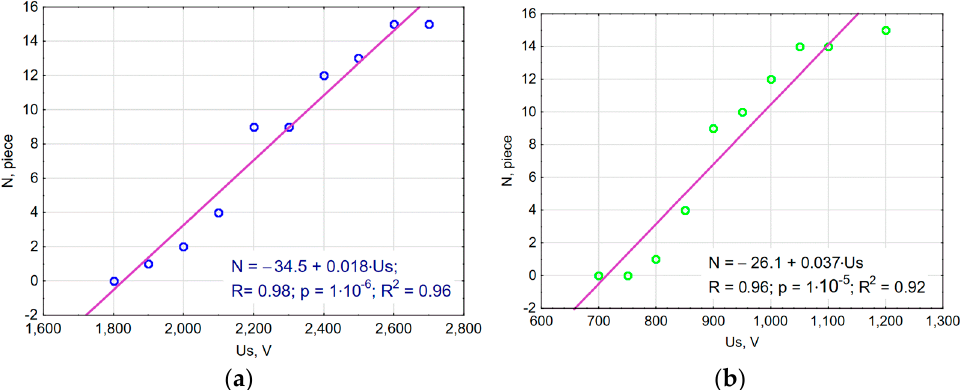
Figure 11. Correlation between the value of the voltage surge and the number of failures: LED lamp A ( a ) and LED lamp B ( b